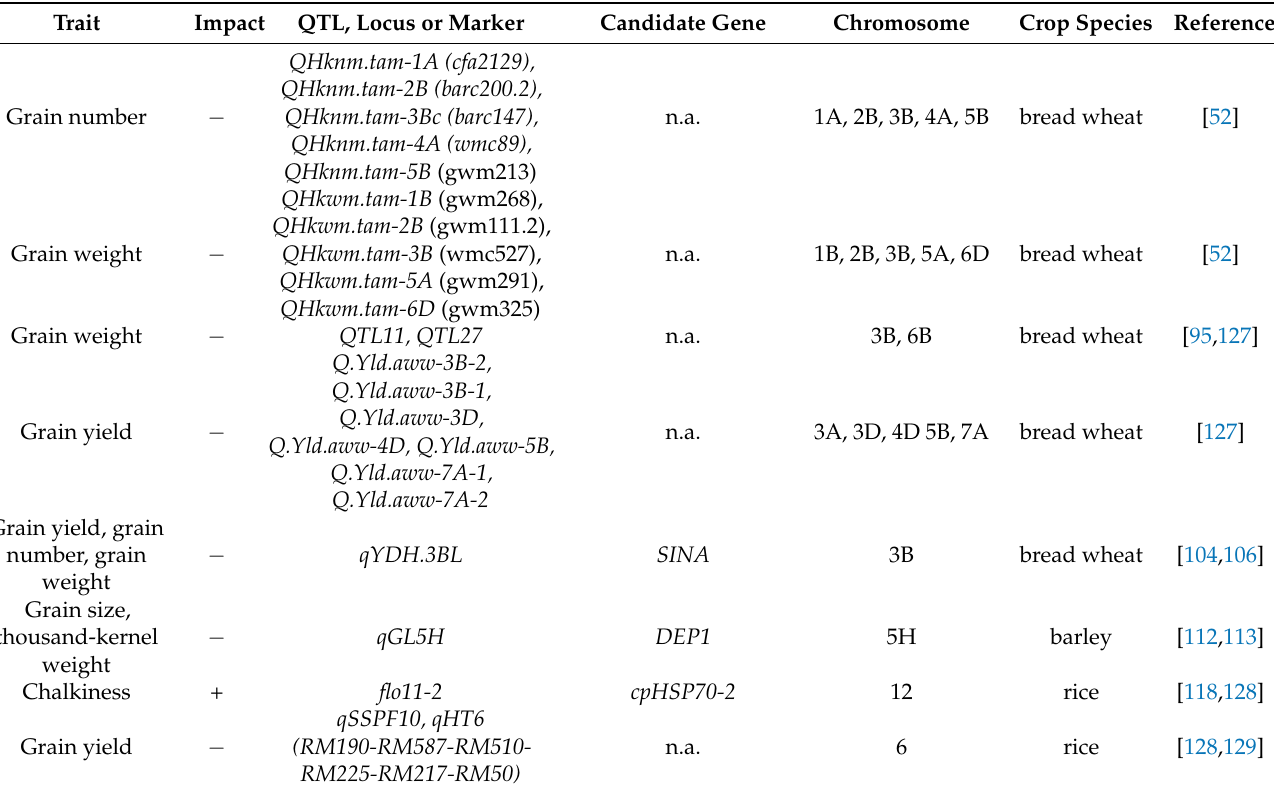
Table 4. Effects of heat on cereal crop grain yield and quality. The ‘+’ sign indicates an increase, and the ‘ − ’sign indicates a decrease in the performance of the trait of interest. n.a.: not